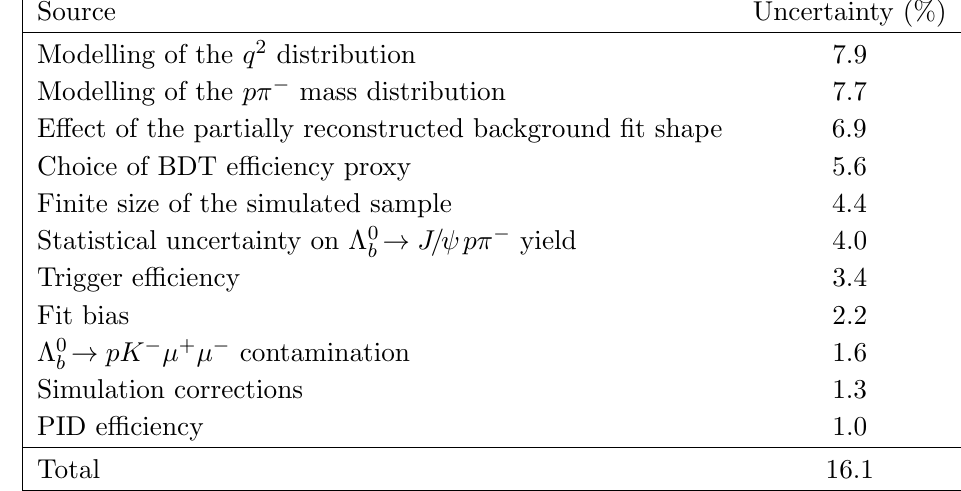
p(cid:25) (cid:0) (cid:22) + (cid:22) (cid:0) branching fraction. b !